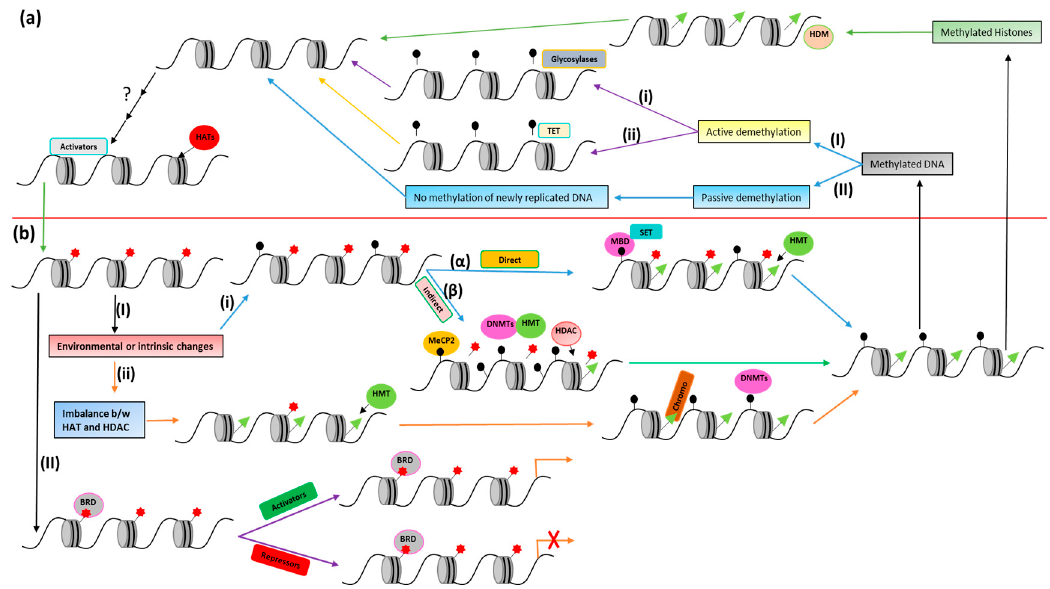
Figure 2. Acetylation and methylation players and their interaction. ( a ) Demethylation and histone acetylation: Methyl marks from chromatin DNA are removed by active demethylation or passive demethylation. ( I ) In active demethylation, ( i ) 5mC (5-methyl cytosine) is converted to thymine and T/G mismatch is repaired by DNA glycosylases (also called direct removal) and ( ii ) the TET (10–11 translocation) enzyme makes various modified forms (5hmC, 5fmC, 5caC, etc.) that are